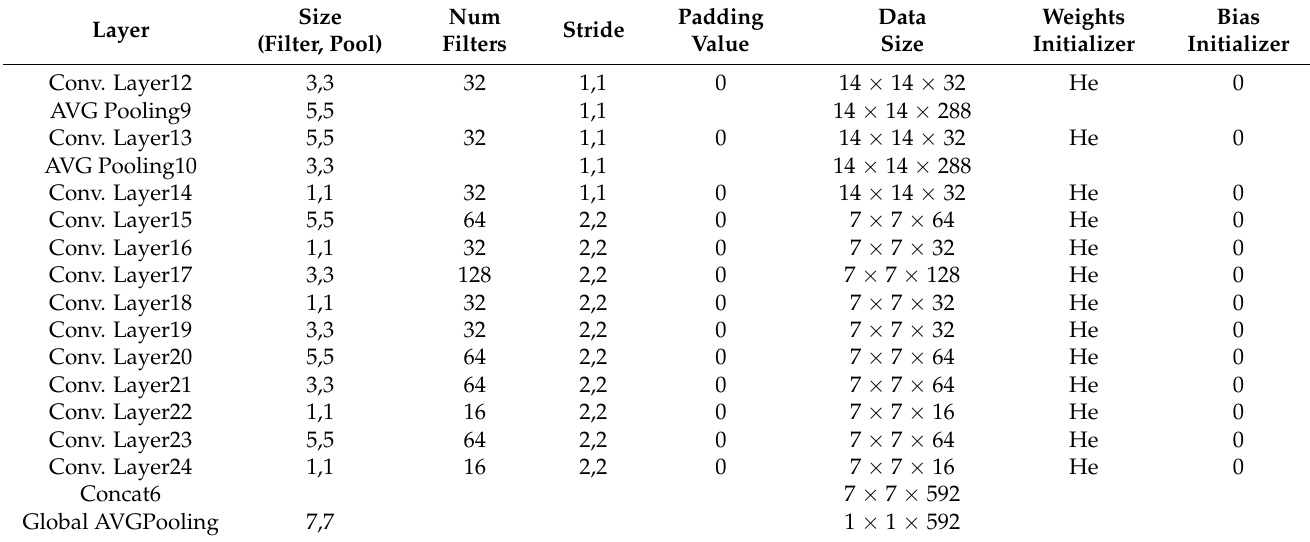
Table 3. Layer Parameters in Figure 10.